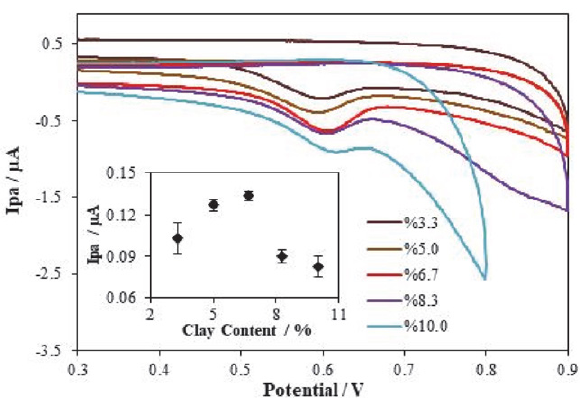
Figure 3. CVs of 1.0 µM KC in BR buffer solution on CCPE with different quantities of sepiolite clay (pH 9.0; scan rate: 0.10 V/s).